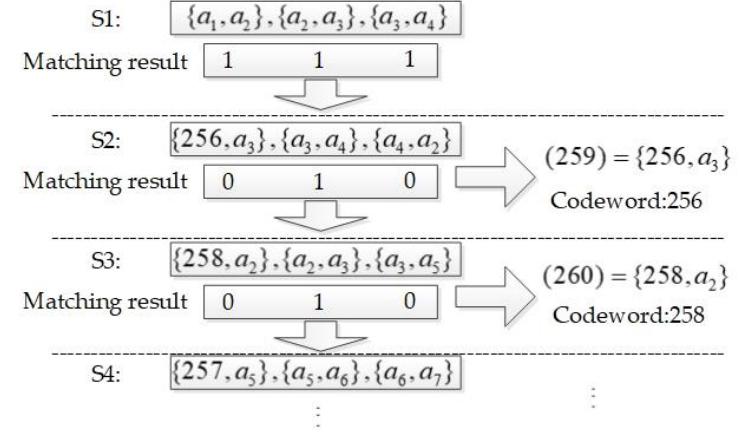
Figure 5. Coding process of the CS-based LZW algorithm for R cs = { 111 }